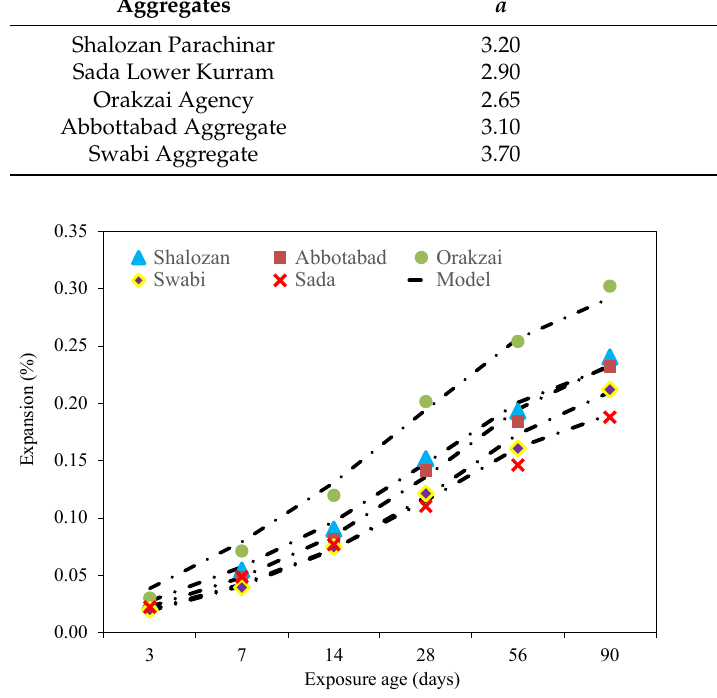
Figure 20. Experimental results versus model prediction of expansion along with exposure ages.